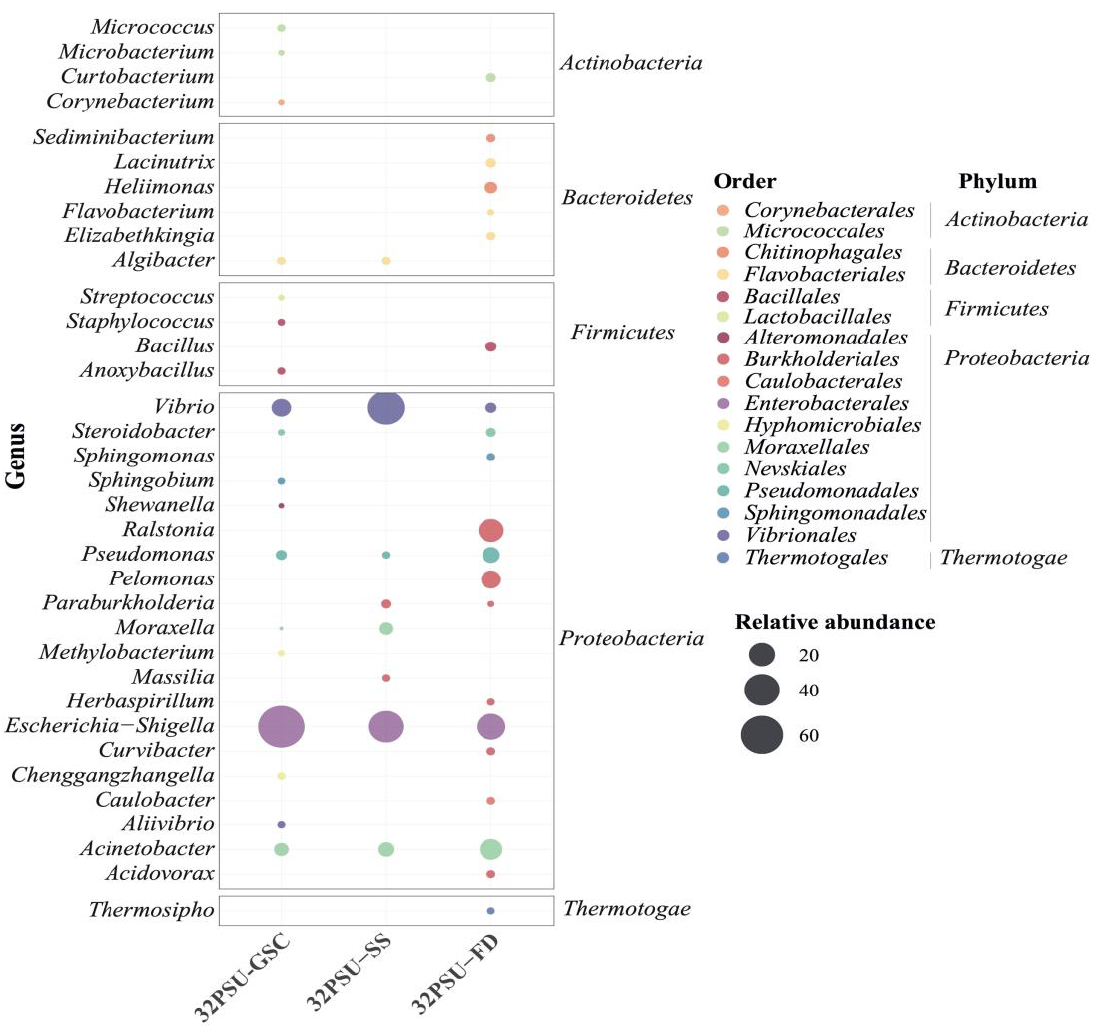
Figure 4. Relative abundance of intestinal Atlantic Salmon microbiota composition at the genus level in seawater groups. 32PSU-GSC: gradual salinity change at 32 PSU group; 32 PSU-SS Salinity shock at 32-PSU group; 32 PSU-FD: Salinity shock at 32 PSU group previously feeding with a functional diet.